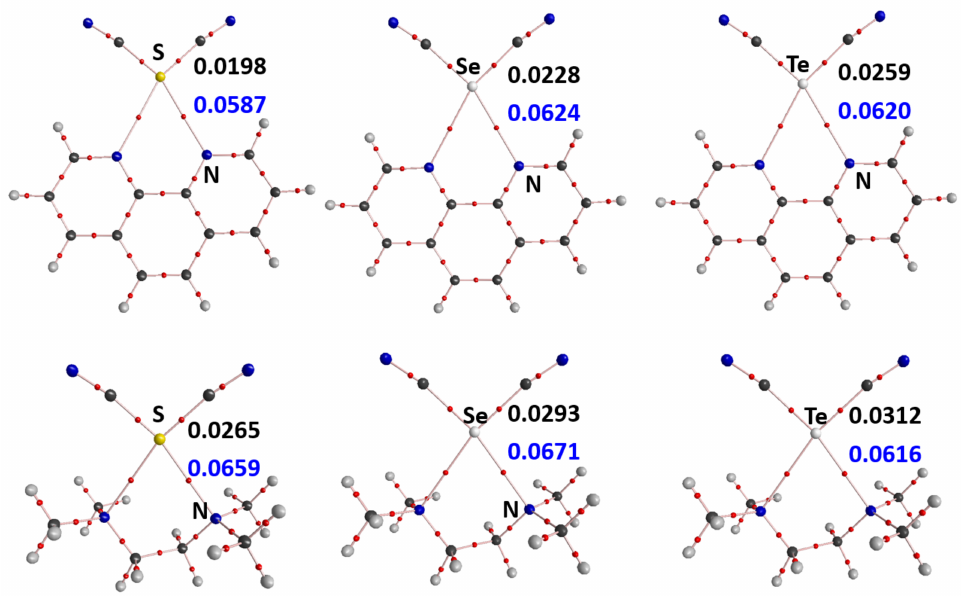
Figure 5. Molecular graphs for the complexes (NC) 2 S ··· Phen, (NC) 2 Se ··· Phen, (NC) 2 Te ···